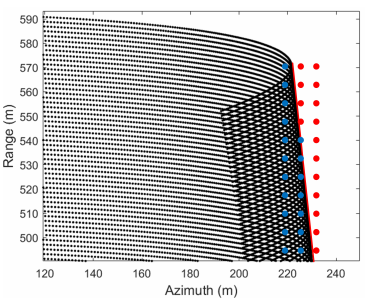
Figure 12. The folding phenomenon of the geometric distortion coordinates, and some measured values depicted by the red and blue